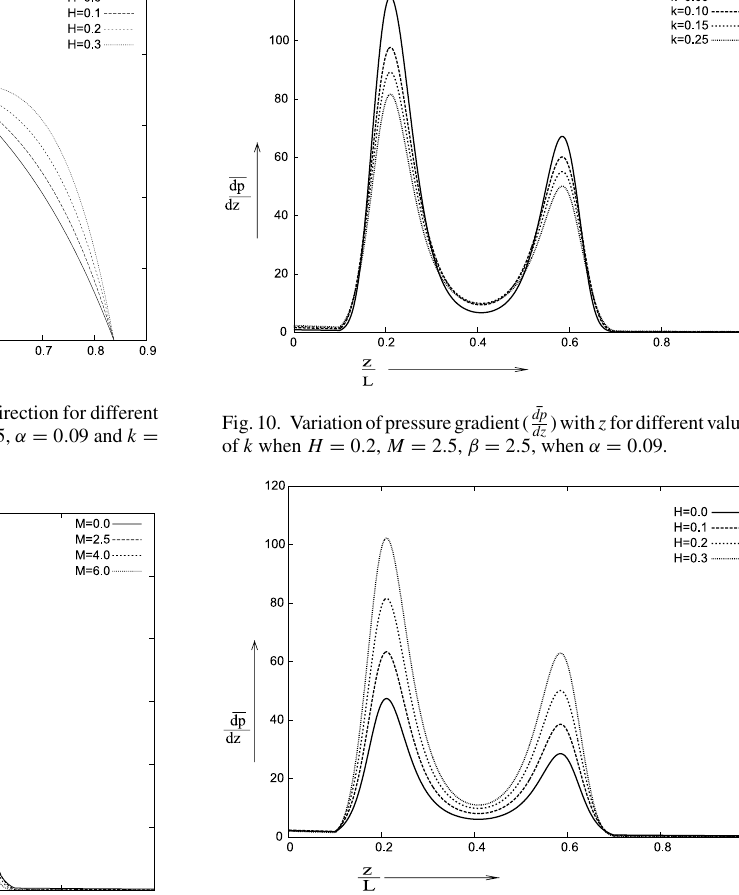
¯ dp dz ) for different values of